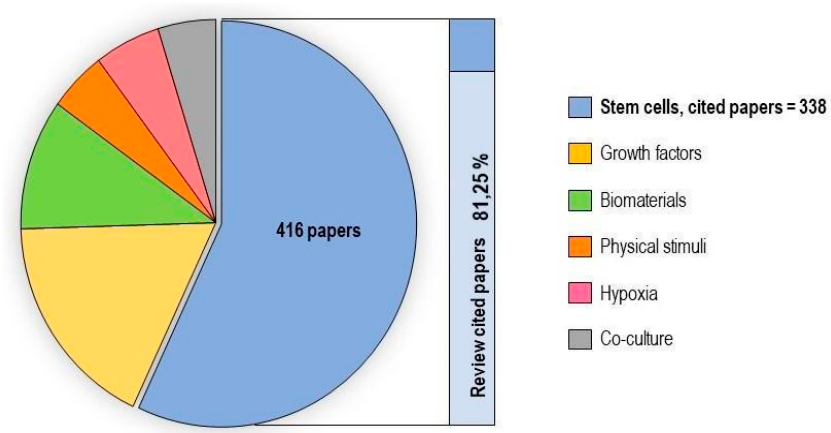
Figure 6. The light blue section shows the percentage/number of papers available on the Scopus database obtained by combining key words in vitro tendon differentiation with stem cells. In the histogram, the relative percentage of cited papers is expressed as well as the relative number in the legend.